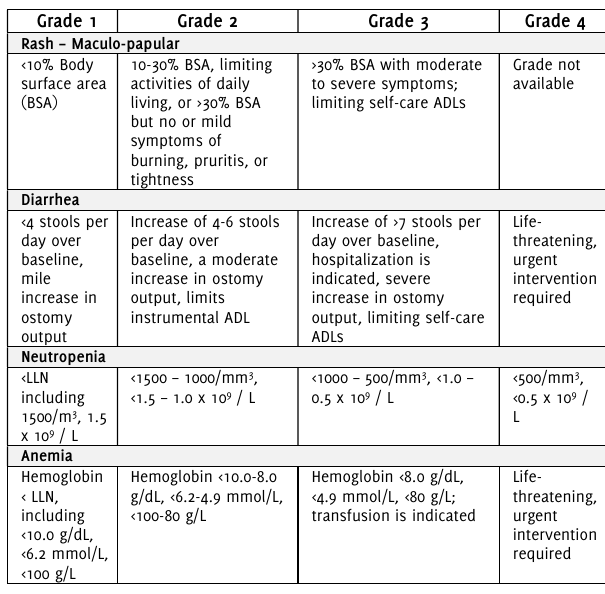
Table 1 . Common Terminology for Adverse Events (CTCAE) v5.0